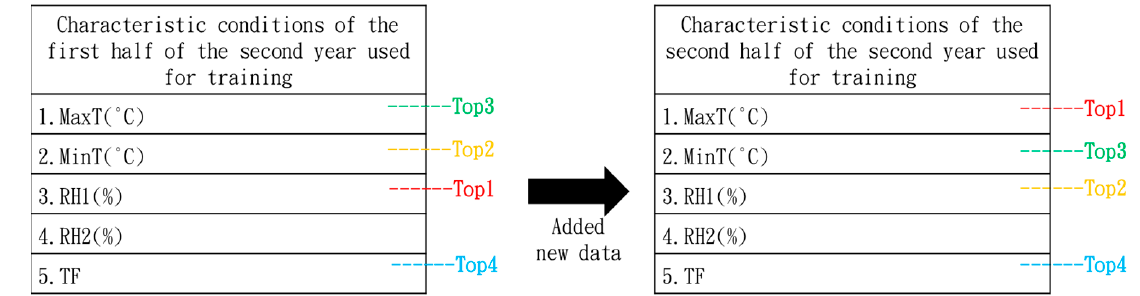
Figure 13. Transfer learning from historical data to real-time data for Experiment 3. Table 10. Results for prediction of the number of aphid pests.